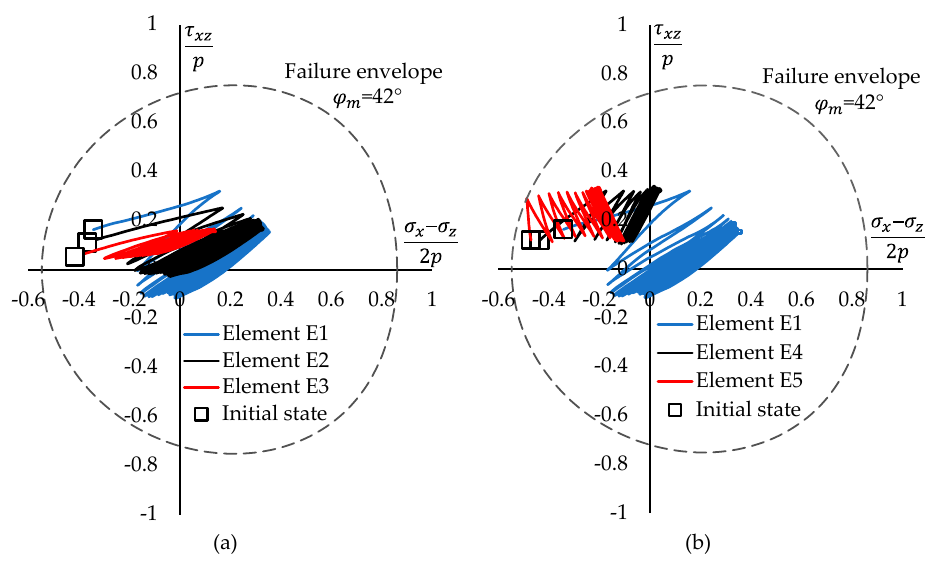
Figure 6. Stress path in the normalised shear stress deviatoric stress plane in terms of ( a ) distance from the pile shaft; ( b ) depth.